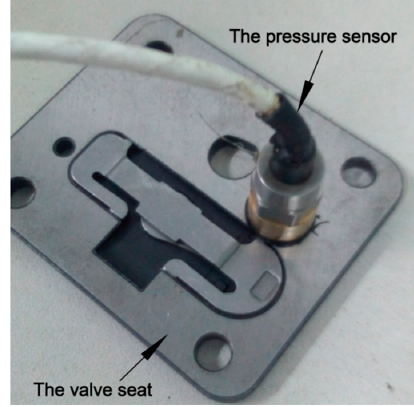
Figure 8. The installation of the pressure sensor.